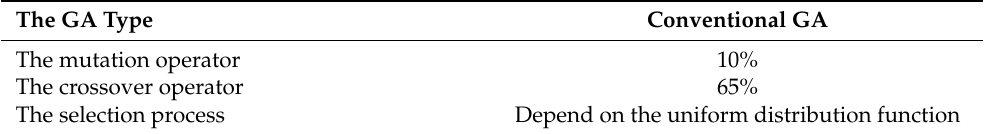
Table 3. Main parameters of the GA.